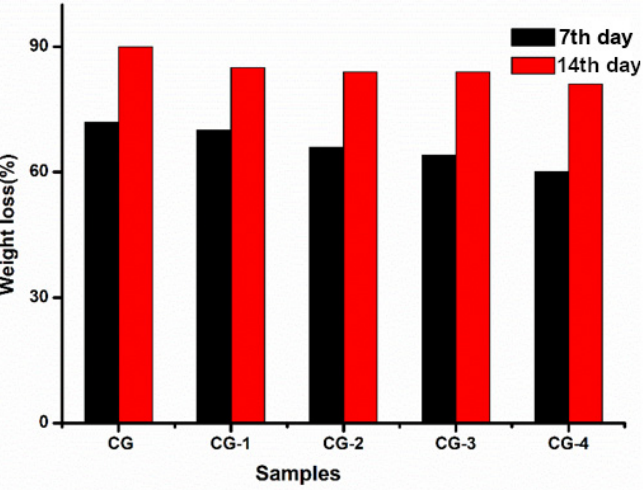
Figure 11. Soil biodegradability nanocomposite films over a period of time.